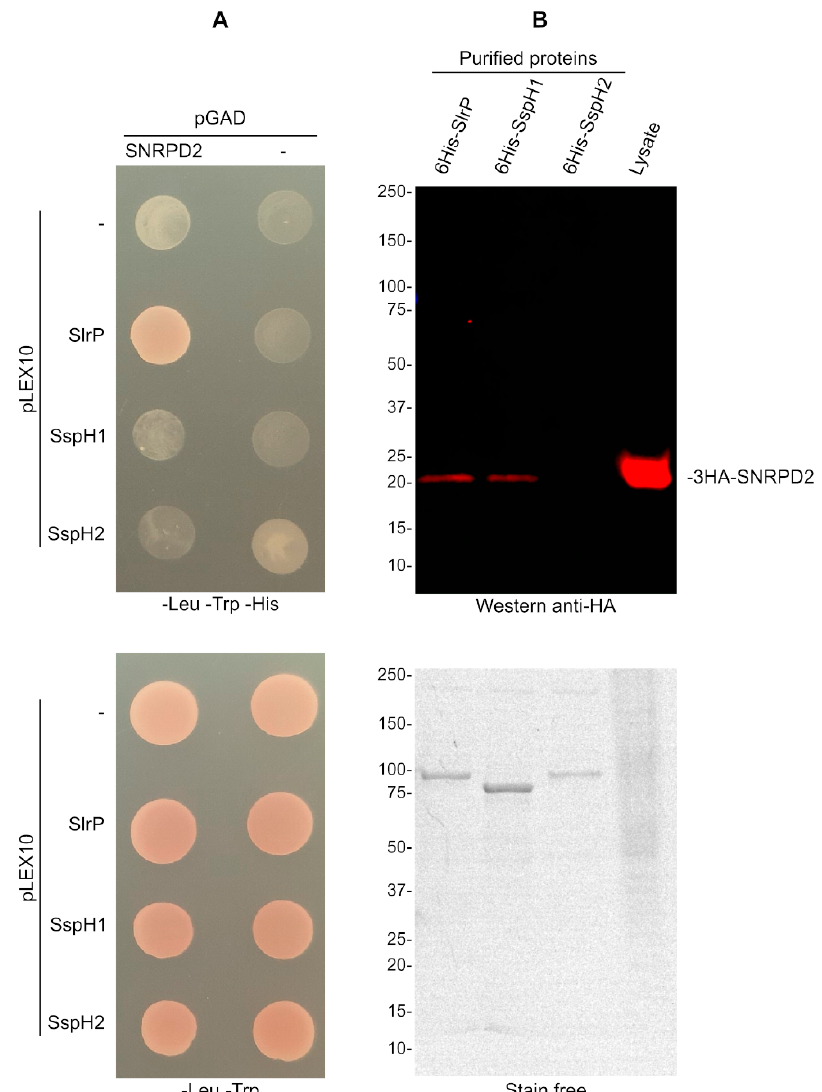
Figure 4. Specificity of the interaction of SNRPD2. ( A ) Derivatives of pLEX10 and pGAD1318 were introduced in yeast strain L40 by transformation. Transformants were selected in media lacking tryptophan and leucine. The interactions between the indicated effectors and SNRPD2 are analyzed by growth in the absence of histidine. ( B ) 6His-SlrP, 6His-SspH1 or 6His-SspH2 bound to Ni-NTA agarose beads were incubated with a cell lysate obtained from HeLa cells expressing 3HA-SNRPD2. Copurification of SNRPD2 with Salmonella effectors was detected by immunoblot with anti-HA antibodies. Stain-free total protein staining was used as loading control. Sizes of molecular weight markers are shown in kDa. Results are representative of two independent experiments.